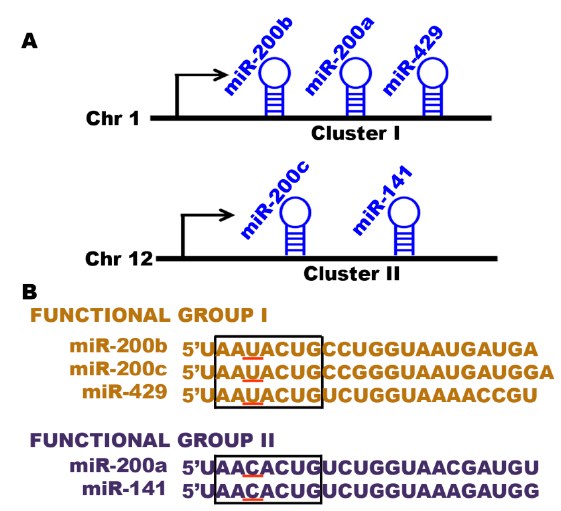
Figure 2. The miR-200 family members. ( A ) The human miR-200 family members are grouped into two clusters: cluster I containing miR-200a, miR-200b, and miR-429 is located on chromosome 1p36, and cluster II contains miR-200c and miR-141, which is located on chromosome 12p13; ( B ) The human miR-200 family members are based on the similarities of their seed sequences (sequence under the box in which one nucleotide is specific for each group (underline)). Members can be divided into two functional groups: functional group I contains miR-200b, -200c, and -429, and functional group II consists of miR-200a and -141, distinguished by a single nucleotide change (U to C).